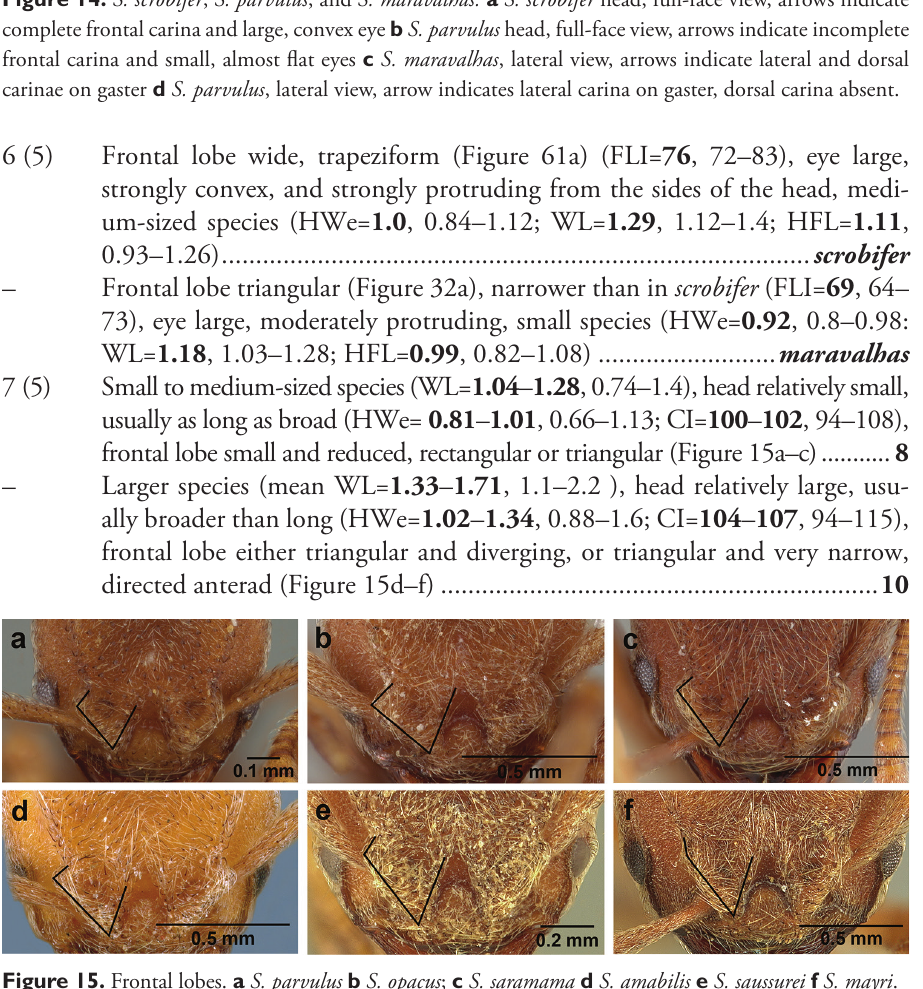
Figure 15. Frontal lobes. a S. parvulus b S. opacus ; c S. saramama d S. amabilis e S. saussurei f S. mayri